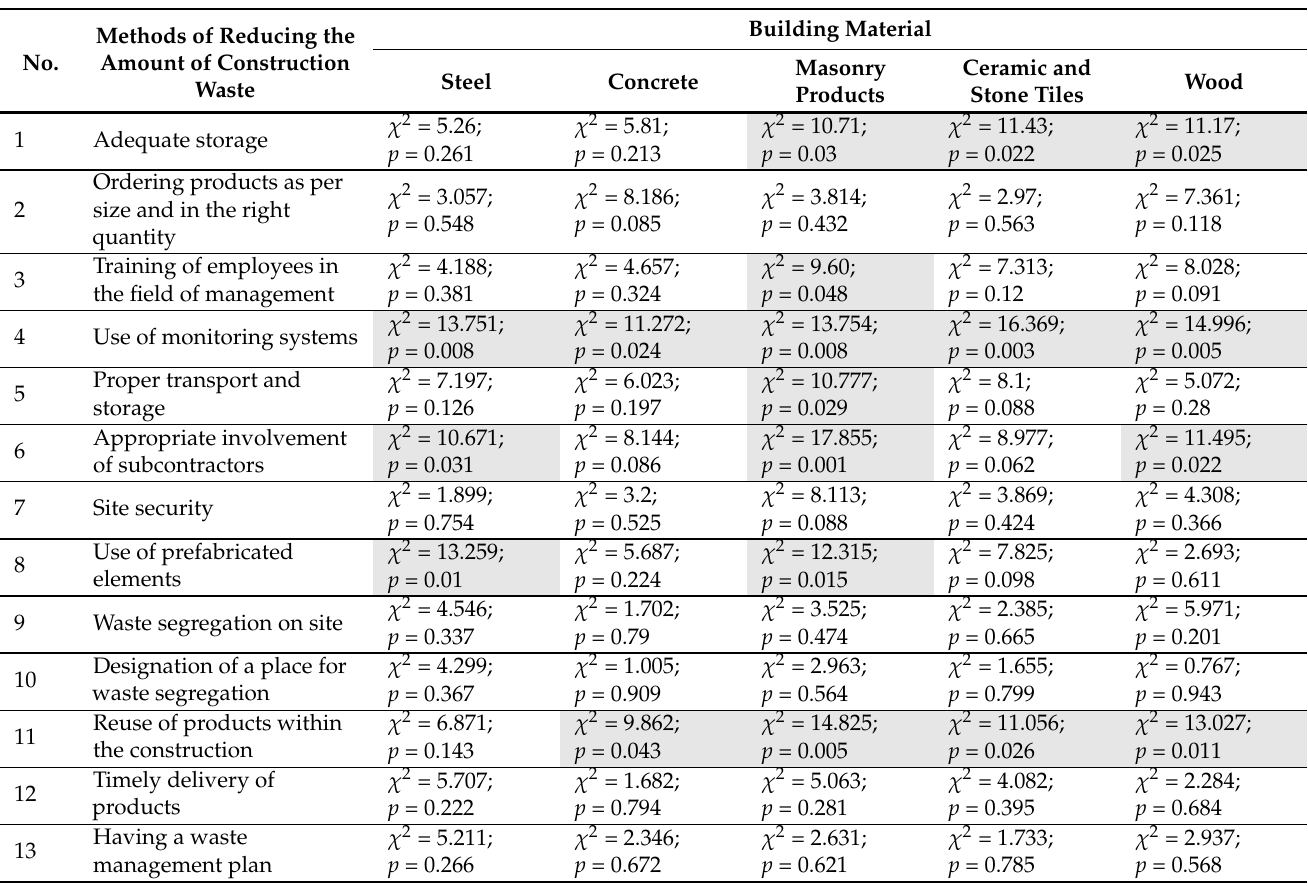
Table 3. Chi-square test